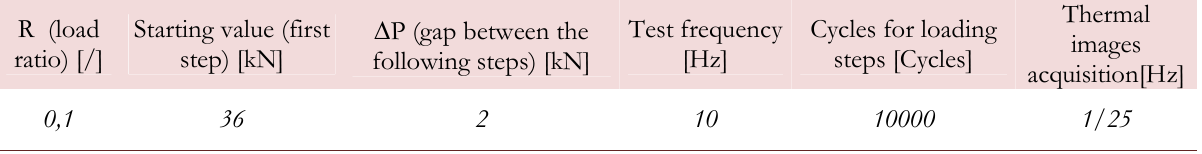
Table 7: Fatigue Test